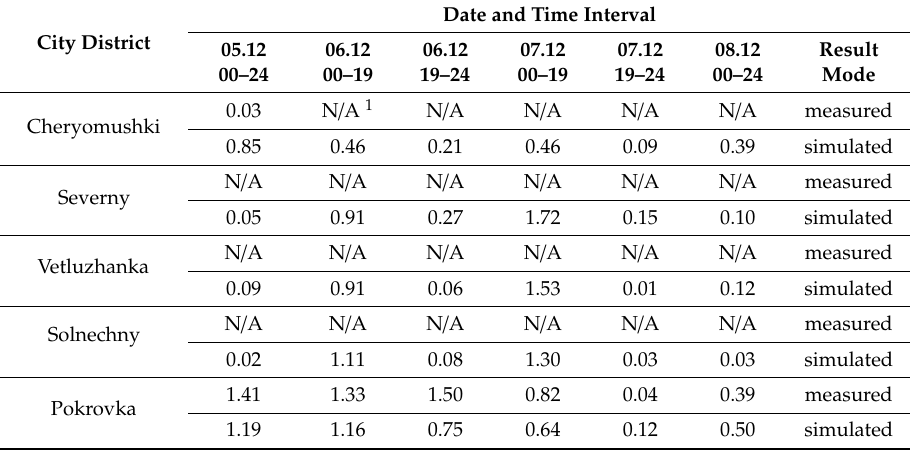
Table 10. PM10 concentrations in shares of peak MPC (160 µ g / m 3 ).